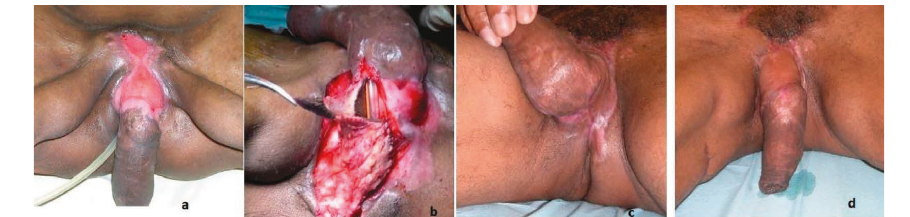
Figure 3: (a) Preoperative after positioning of the testicles on the internal side of the thigh before. (b) Intraoperative with a partial reconstruction of the urethra by local skin flap and full-thickness skin graft. (c-d) Result 1 year after.